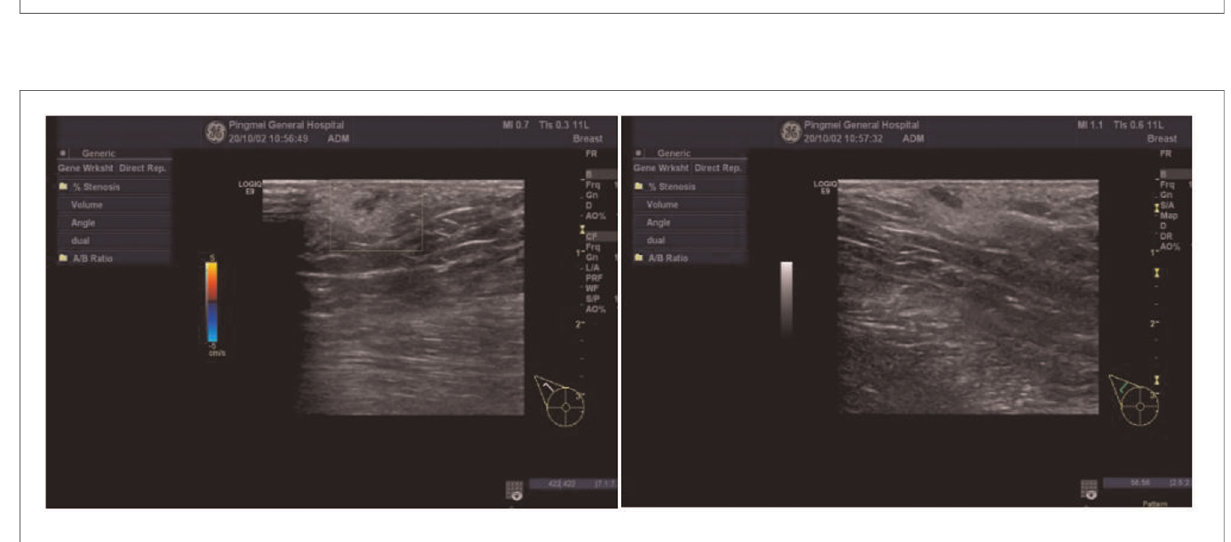
FIGURE 5 Preoperative enhanced MRI. The spine was diastematomyelia, with tethered spinal cord and terminal fi lament lipoma, infusion of the lamina at L3-5 segments, and local lamina thinning.